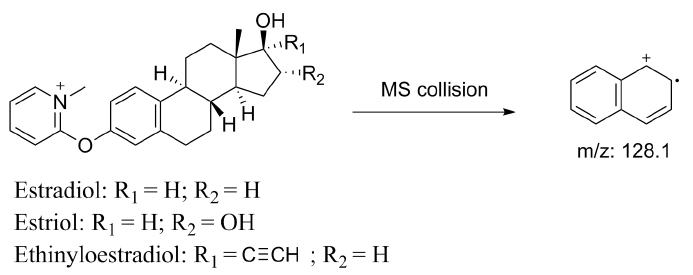
Figure 5. Fragmentation path of estradiol, estriol and ethinyloestradiol.